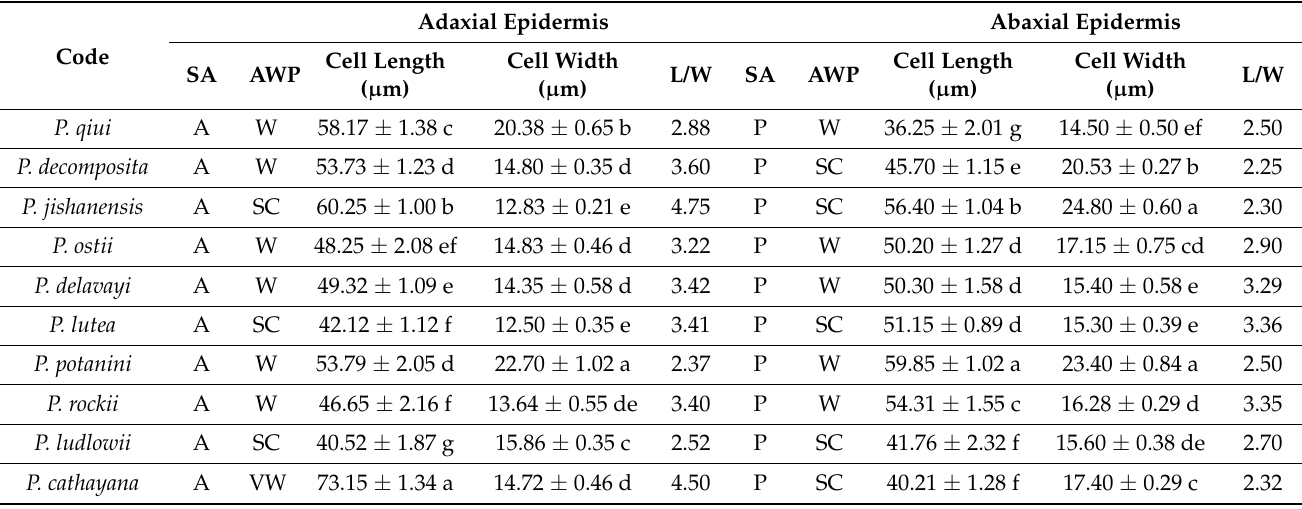
Table 2. Characteristics of leaf epidermis cells of ten wild tree peonies.